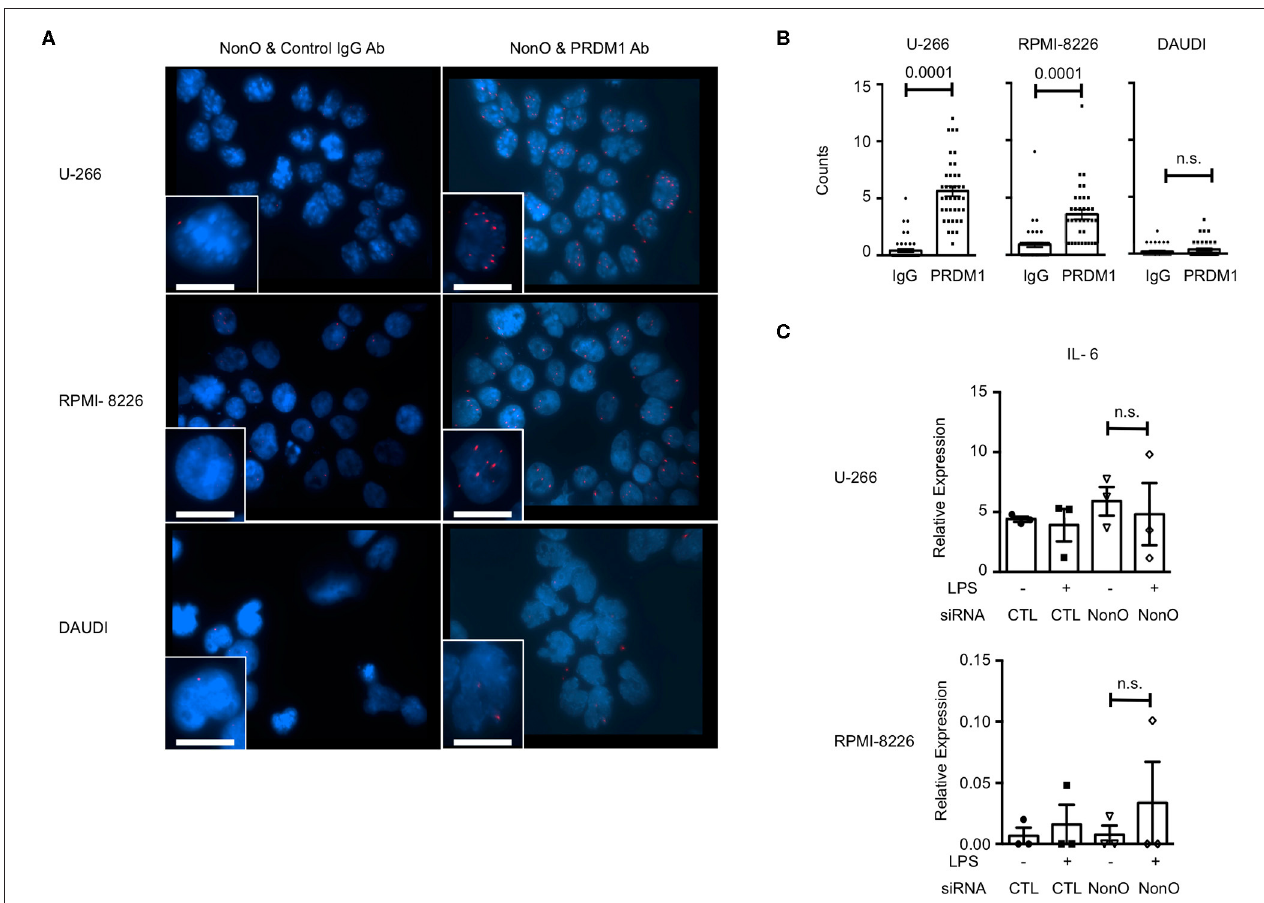
FIGURE 6 | NonO binds with PRDM1 but does not regulate IL-6 in myeloma cells. (A) Binding between PRDM1 and NonO in human myeloma cells was visualized by PLA (red color) and nuclei were stained with DAPI (blue). Left columns are control groups of PLA (anti-NonO and control IgG) and right columns are experimental groups (anti-NonO and anti-PRDM1). Scale bar = 15 µ m. Images were taken at 60x magnification. A representative image from three independent experiments. (B) PLA signals in each nucleus were quantified by Imaris software ( n = 30–40). Significance determined by Mann Whitney test. (C) 48h NonO or control siRNA post transfection, cells were cultured with or without LPS (1 µ g/ml) for last 6h and level of IL-6 measured by qRT-PCR. Bar graph is a mean ± SEM ( n = 3). Significance determined by unpaired t